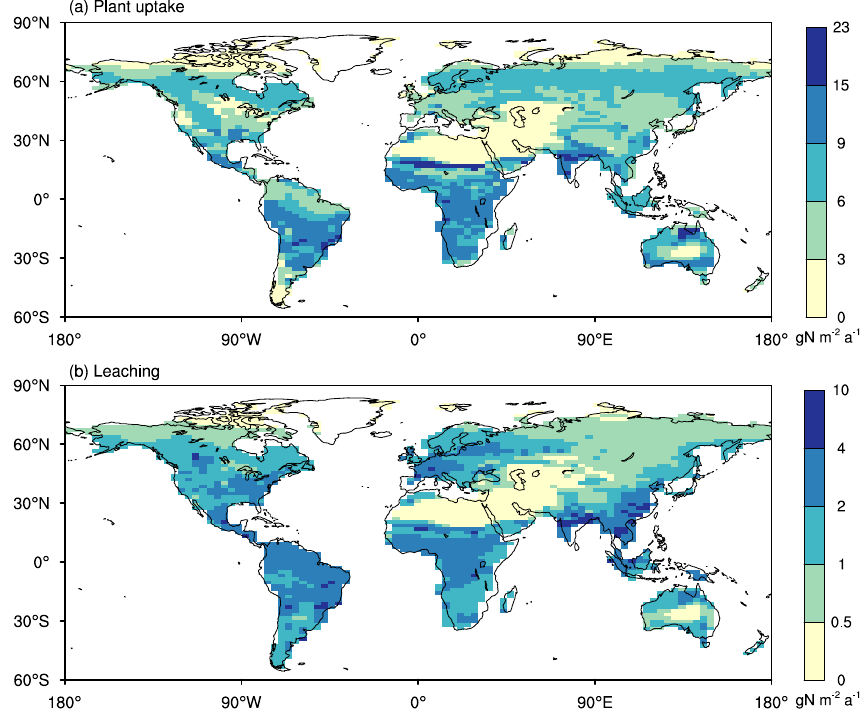
Fig. 5. Mean 1980–1999 plant uptake (a) and leaching (b) of nitrogen simulated by UVic-CN.